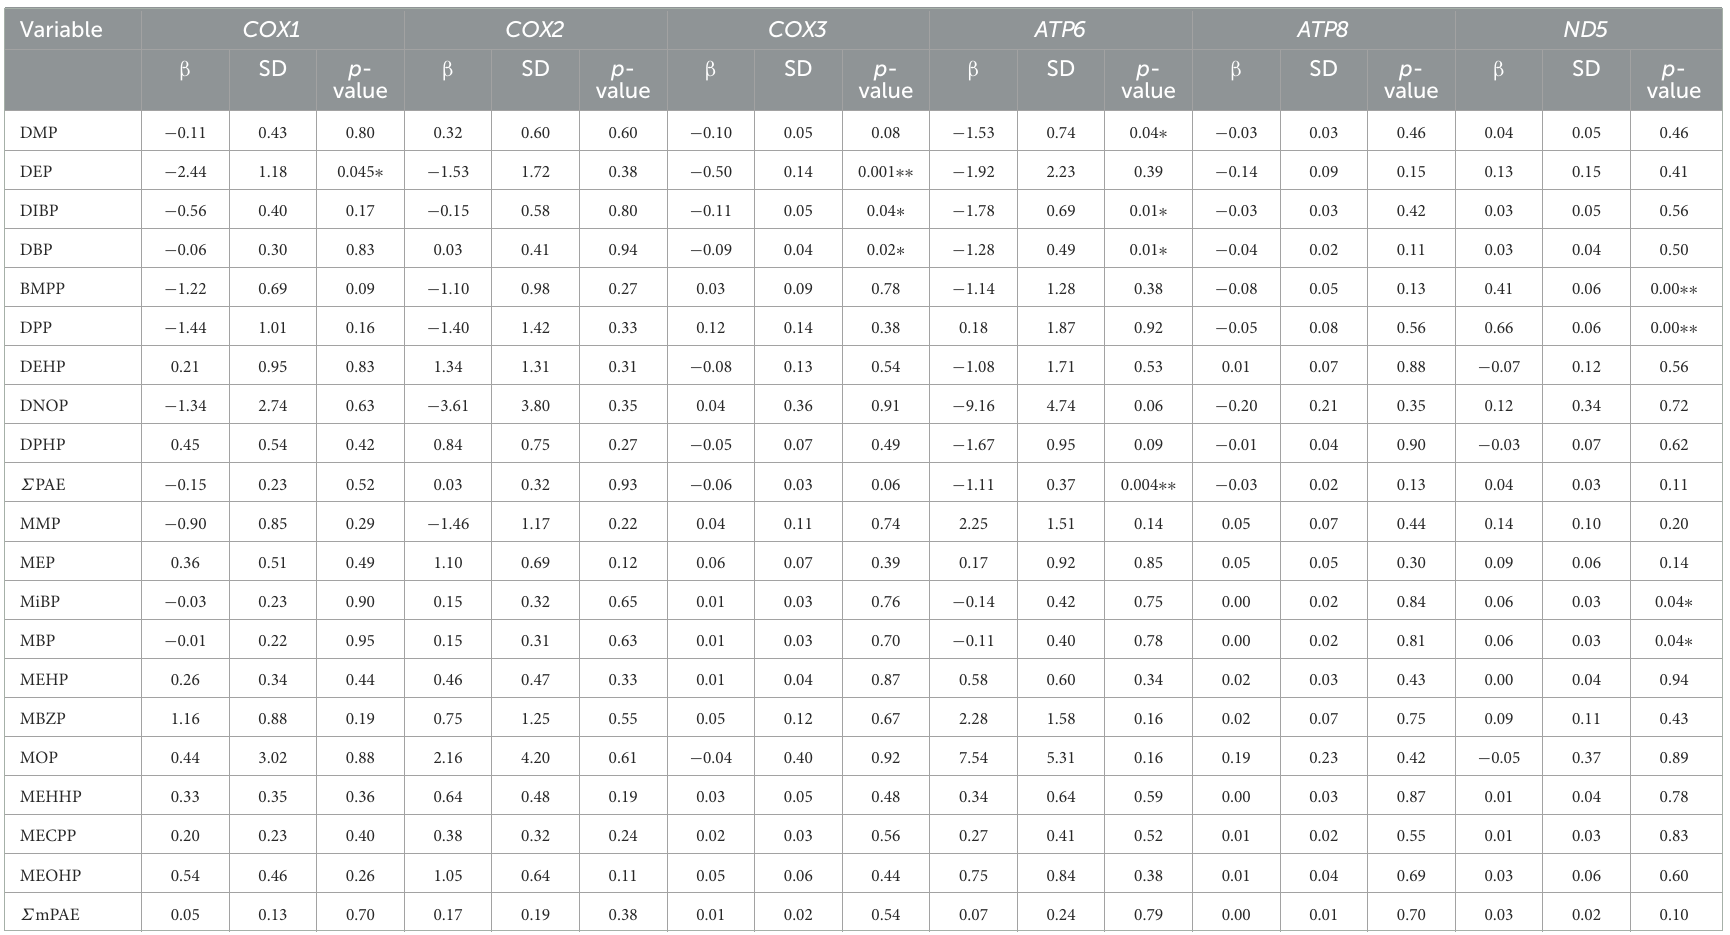
TABLE 5 The associations between the mtDNA methylation levels with PAEs and mPAEs concentrations.